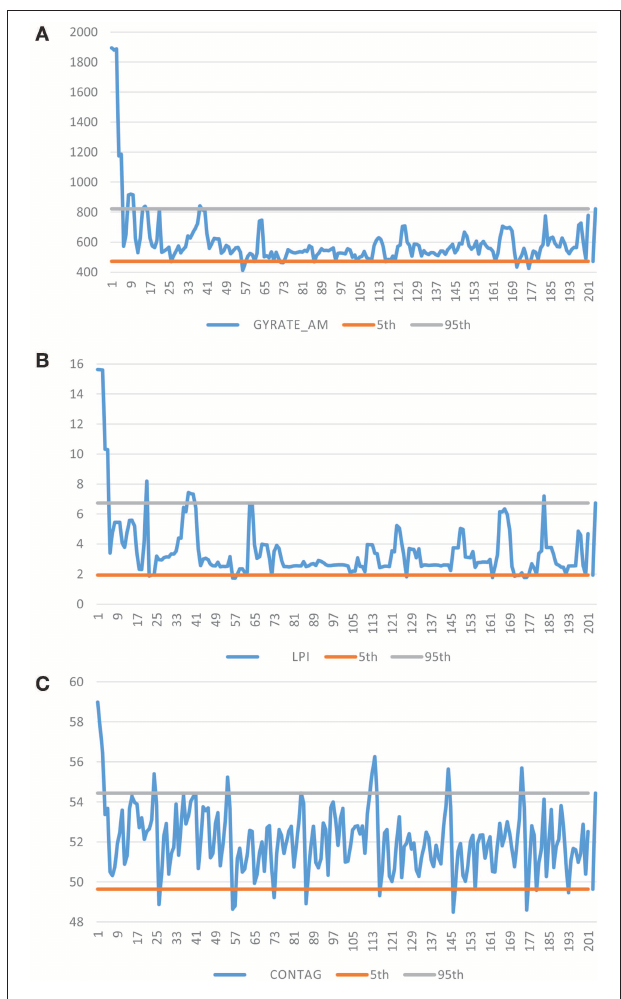
FIGURE 6 | Temporal plot of three landscape metrics within the Prospect Creek landscape. (A) Correlation Length (Gyrate_AM), (B) Largest Patch Index (LPI), (C) Contagion (CONTAG). The blue line represents the value of the landscape metric over the simulation time. The gray line is the upper 95th percentile of the simulated range, and the orange line is the lower 5th percentile of the simulated range.